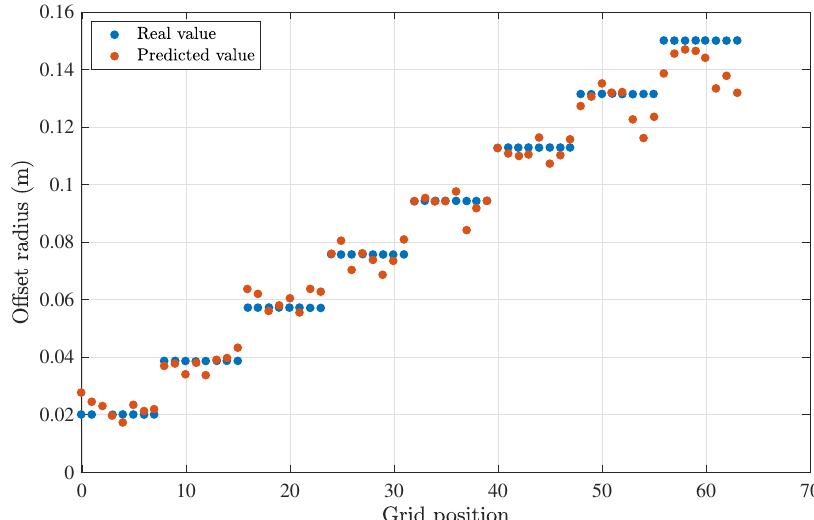
Figure 17. Comparison between the predicted and expected offset radius for a Tx–Rx distance of 1m.